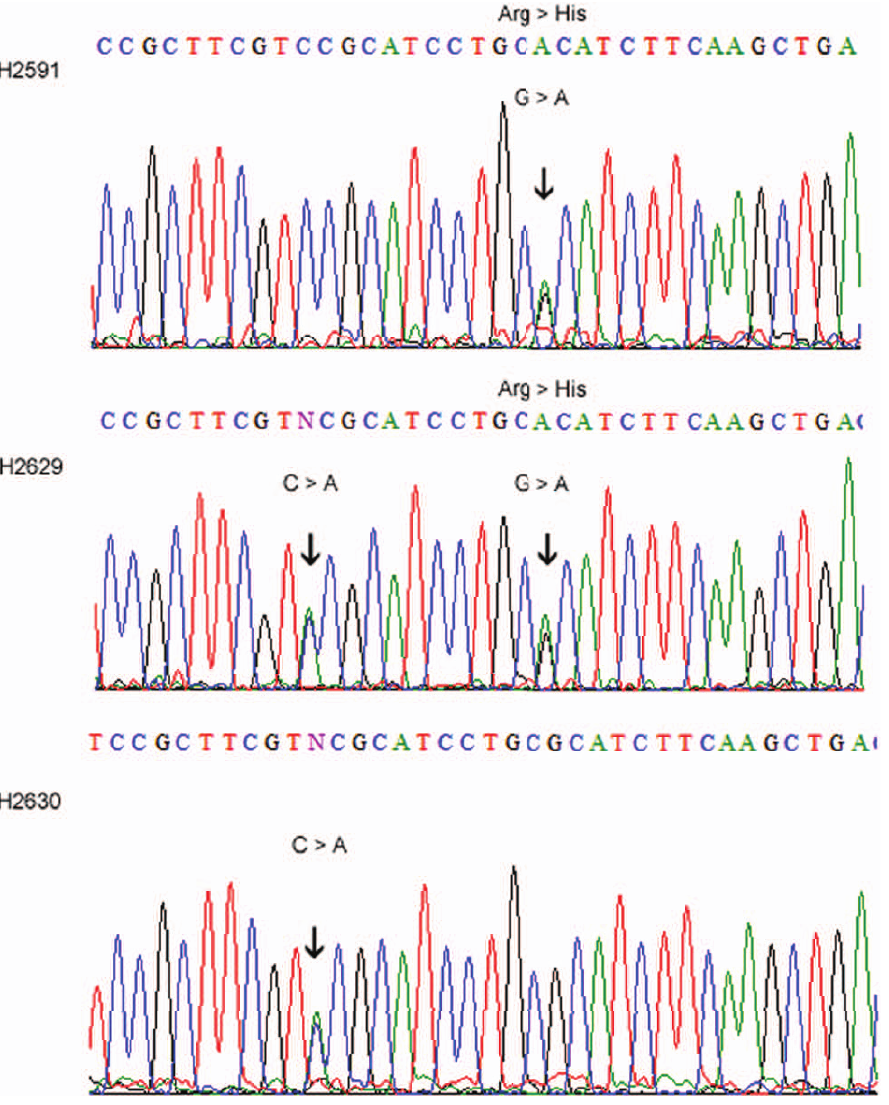
Figure 1. DNA electropherograms of a family with the p.Arg423His mutation. H2591shows the p.Arg423His mutation (arrow, top), her son (H2629) shows the p.Arg423His mutation and the c.1257C . A variant, and her daughter (H2630) shows the c.1257C . A change, but lacks the mutation.